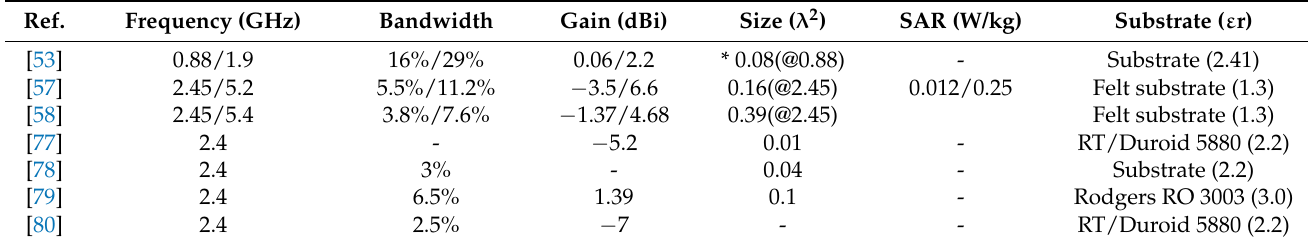
Table 1. Performances among the CRLH TL-based wearable